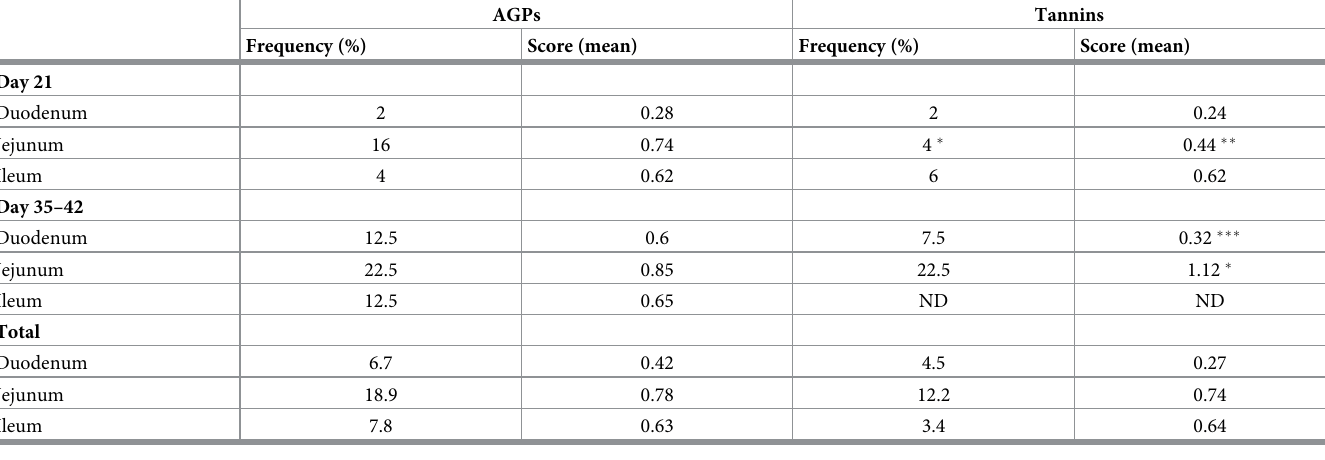
Table 5. Frequency and score of intestinal gross lesions5 (Experiment 2).